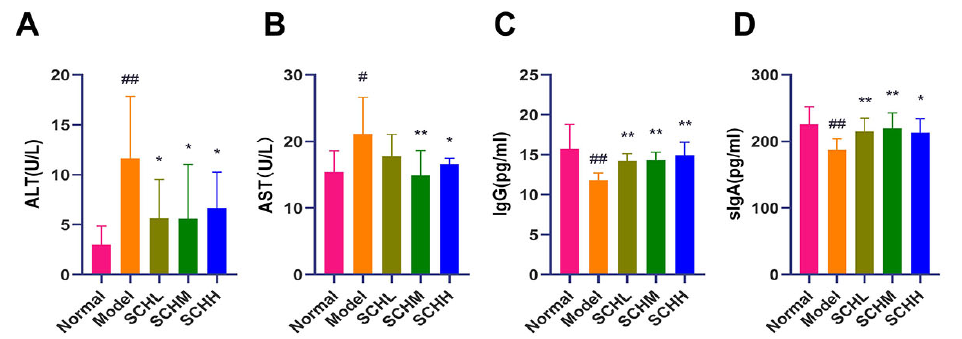
Figure 3. Effects of SCH on serum ALT ( A ), AST ( B ), IgG ( C ), and small intestinal sIgA ( D ) levels in immunosuppressed mice. The results are presented as the means ± SD (n = 10). # p < 0.05, ## p < 0.01 compared with the normal group, * p < 0.05, ** p < 0.01 when compared with the model group. To observe the effect of SCH on intestinal morphology, small intestine, and colonic tissues were collected for histopathological analysis (Figure 4). H&E staining revealed that the small intestine and colon in the normal group had normal histology and an intact surface structure. In the model group, the villi of the small intestine became shorter and slightly swollen and the depression depth decreased. The model mice group showed severe colon injury. When compared with the model group, the damage to the small intestine and colon was relieved in the SCH groups. The results revealed that Cy damaged the surface structure of the intestinal tissues and SCH improved the intestinal mucosal damage in immunosuppressed